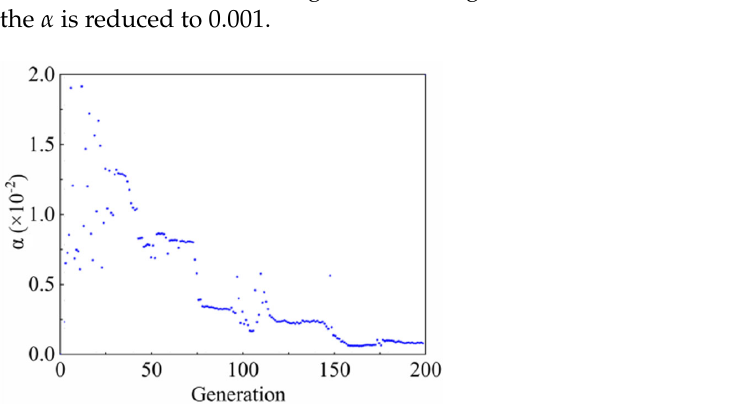
cess has converged.